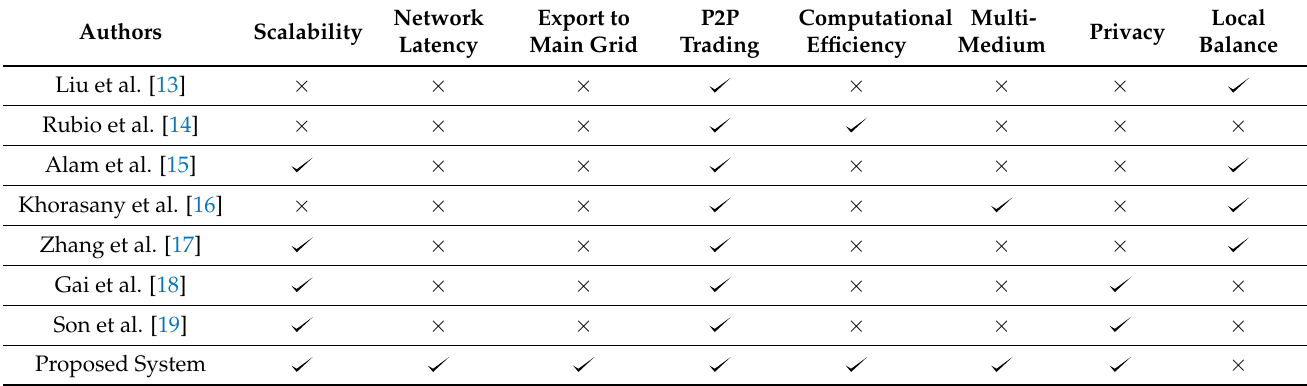
Table 1. Comparison of our proposed system with existing